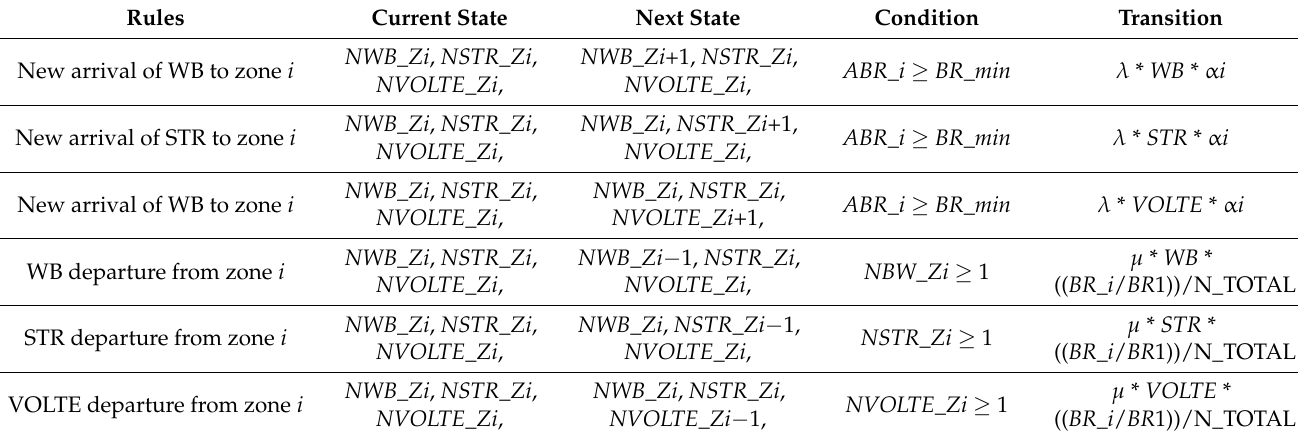
Table 2. Rules for generating the transition states of the